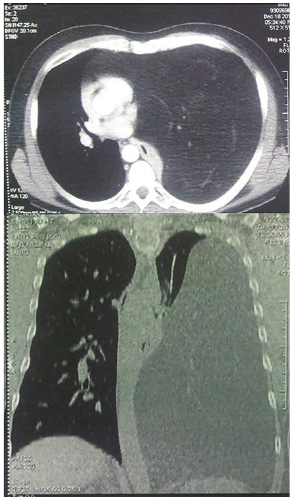
Figure 2: Chest CT scan reveals a huge mediastinal mass with compressive effect on neighboring structures and mediastinal shift.